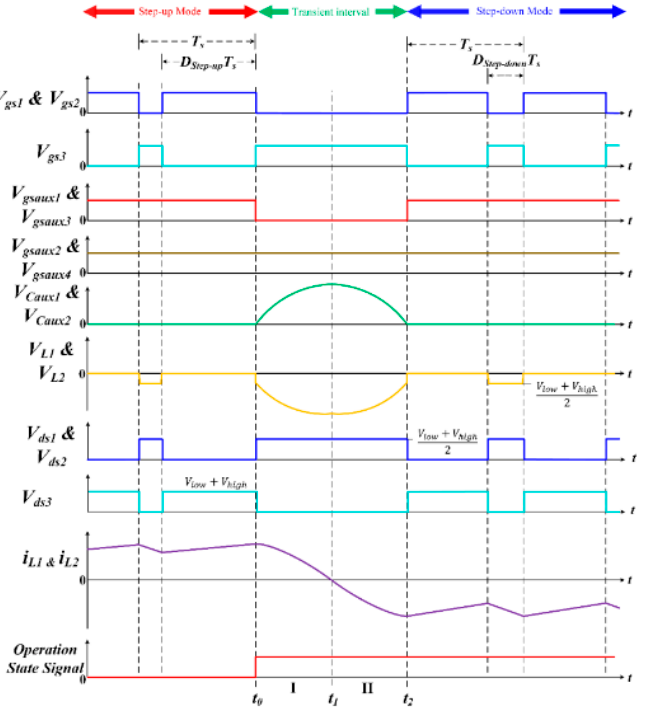
Figure 10. The process of the transition from the step-up mode to the step-down mode.